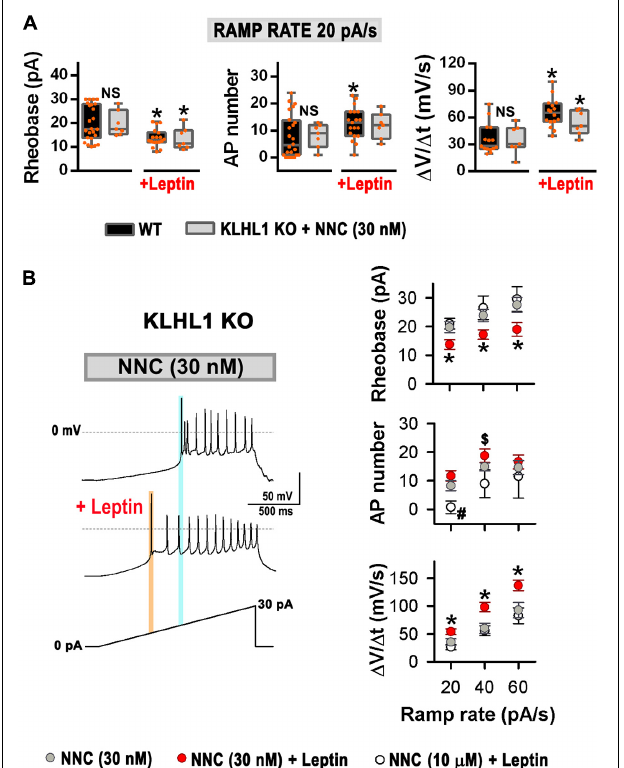
FIGURE 7 | Resistance to leptin in KLHL1 KO neurons is restored by partial blockade of T-type currents. (A) Leptin effect on rheobase (pA), number of action potentials and rate of membrane potential depolarization (Slope = (cid:49) V/ (cid:49) t , mV/s) in WT (control, n = 24, 24, 15; + leptin, n = 18, 19, 16) and [NNC (30 nM)]-treated KLHL1-KO (control, n = 7, 7, 7; + leptin, n = 7, 7, 7) neurons in response to a ramp rate of 20 pA/s. NS, no significant difference between WT and [NNC (30 nM)]-treated KLHL1-KO, P > 0.05, t -test. *Significantly different from its respective control), P < 0.05, t -test. WT: Rheobase: t = 3.285 (df = 40), AP number: t = 2.257 (df = 41), Slope: t = 5.059 (df = 29). [NNC (30 nM)]-treated KLHL1-KO: Rheobase: t = 2.368 (df = 12), Slope: t = 2.362 (df = 12). (B) Left: Examples of neuronal firing in KLHL1-KO neurons preincubated with NNC (30 nM) before and after the addition of leptin [NNC (30 nM) + leptin (100 nM)]. V H = 75 mV, AP triggering was elicited by a 20 pA/s ramp. Light blue and orange lines indicate the rheobase in the NNC treatment and after the addition of leptin ([NNC + leptin] treatment). Right: Rheobase (pA), number of action potentials and rate of membrane potential depolarization (Slope = (cid:49) V/ (cid:49) t , mV/s) in response to 20, 40 and 60 pA/s ramps in [NNC (30 nM)]-treated ( n = 7), [NNC (30 nM) + leptin]-treated ( n = 7) and [NNC (10 µ M) + leptin]-treated ( n = 5) KLHL1-KO neurons. *Significantly different from NNC (30 nM) and [NNC (10 µ M) + leptin]. # Significantly different from NNC (30 nM) and [NNC (30 nM) + leptin]. $ Significantly different from [NNC (10 µ M) + leptin]. P < 0.05, ANOVA. Rheobase: F 2 , 16 = 3.867 for 20 pA/s, F 2 , 16 = 4.188 for 40 pA/s and F 2 , 16 = 3.648 for 60 pA/5. AP number: F 2 , 16 = 8.550 for 20 pA/s, F 2 , 16 = 4.081 for 40 pA/s. Slope: F 2 , 16 = 5.908 for 20 pA/s, F 2 , 16 = 6.832 for 40 pA/s, F 2 , 14 = 4.770 for 60